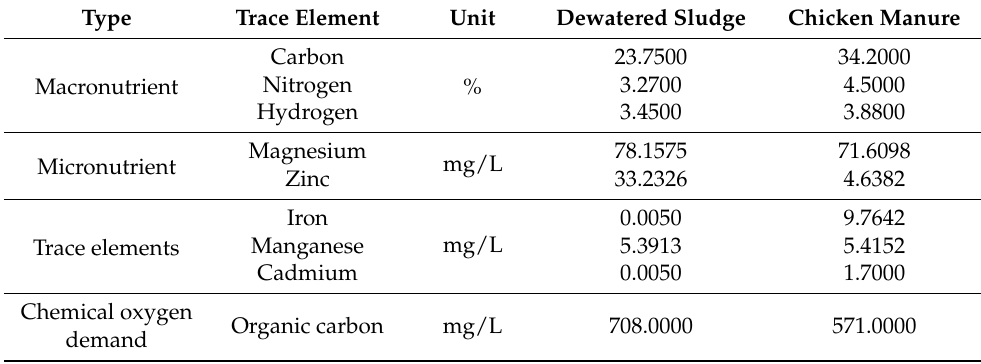
Table 1. Proximate analyses of dewatered sludge and chicken